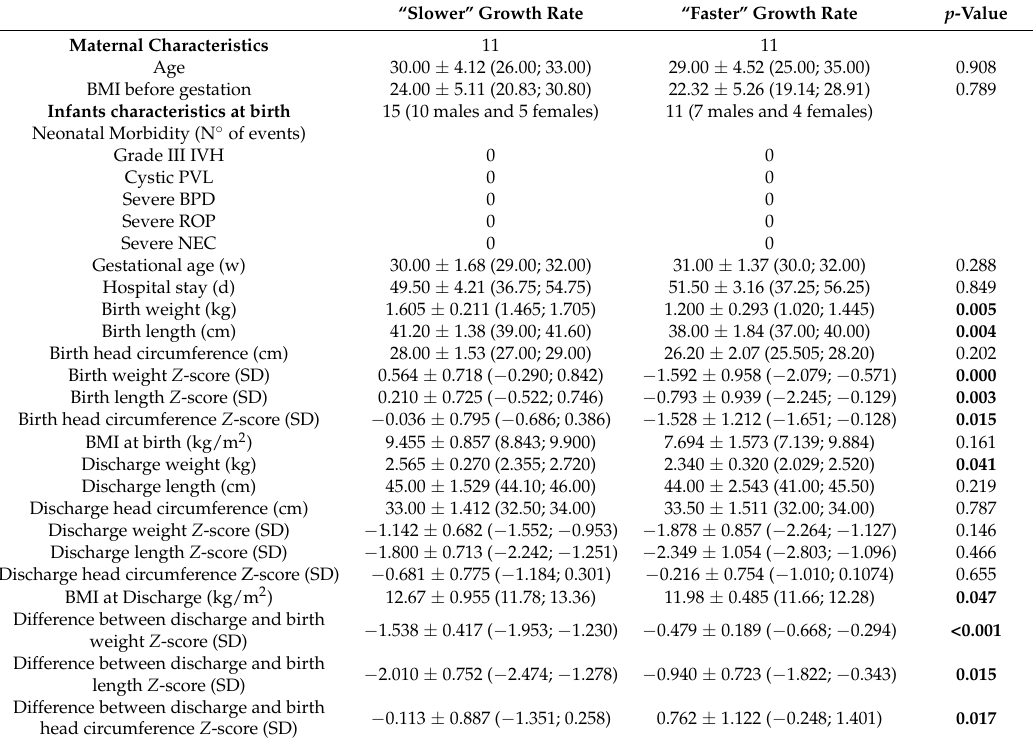
Table 1. Maternal and preterm infants’